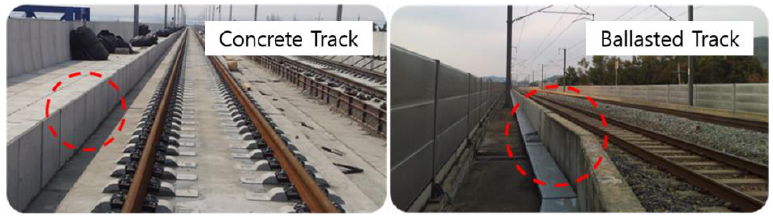
Figure 2. DCPs for high-speed railway bridges in South Korea.